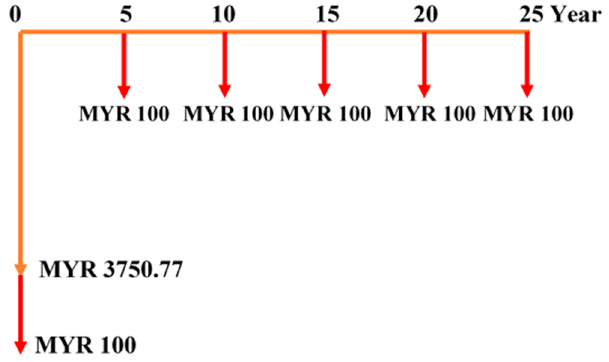
Figure 8. Solar PVT system cash flow diagram.